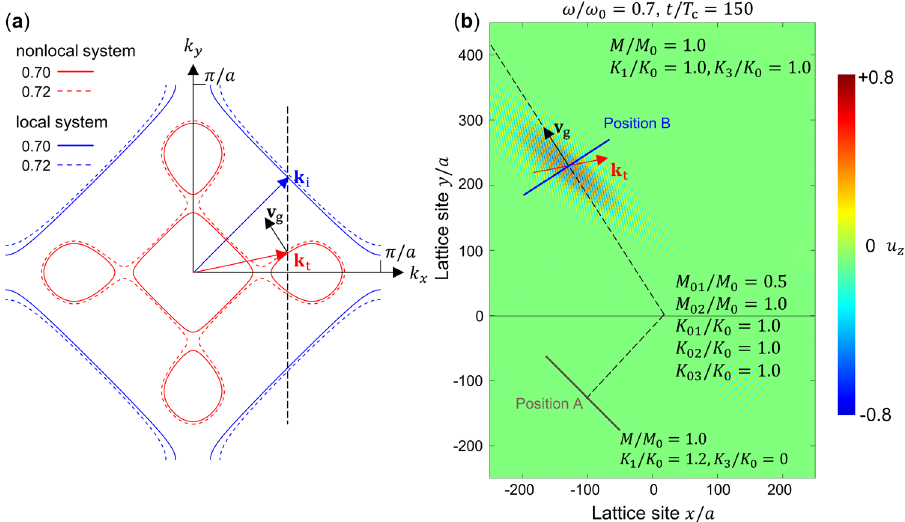
Fig. 8 Negative refraction at an interface as illustrated in Fig. 7. a Iso-frequency curves for the nonlocal system, with the same parameters as in Supplementary Fig 4, and the local system, with parameters M = M 0 ¼ 1 ; K 1 = K 0 ¼ 1 : 2, and K 3 = K 0 ¼ 0. The solid lines correspond to the carrier frequency ω = ω ¼ 0 : 7 of the Gaussian pulse. The blue arrow represents the incident wave vector, k c 0 vector, k t , and group velocity vector, v g , is possible. b Snapshot of simulated pressure fi elds at t = t c ¼ 150, with t c ¼ 2 π = ω c . The interface parameters (cf. Fig. 7) are M 01 = M 0 ¼ 0 : 5 ; M 02 = M 0 ¼ 1 : 0 ; K 01 = K 0 ¼ 1 : 0 ; K 02 = K 0 ¼ 1 : 0, and K 03 = K 0 ¼ 1 : 0. The black dashed straight lines indicate the propagation path of the incident and the refracted wave. In the nonlocal region, the wave propagation direction agrees well with the group velocity vector as derived in a . An animated version of b is provided in Supplementary Movie 1. The displacement component u z for the two cuts perpendicular to the propagation direction at positions A (brown) and B (blue), respectively, is shown in Supplementary Fig